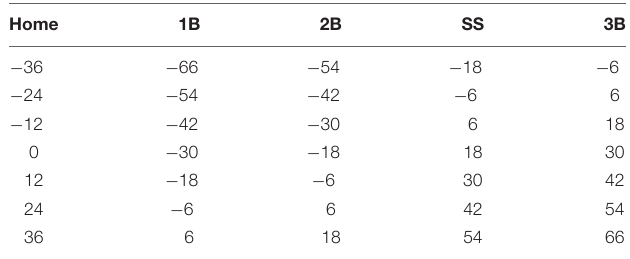
ground of 15 m (50 ft) side-length, practice baseball diamond.